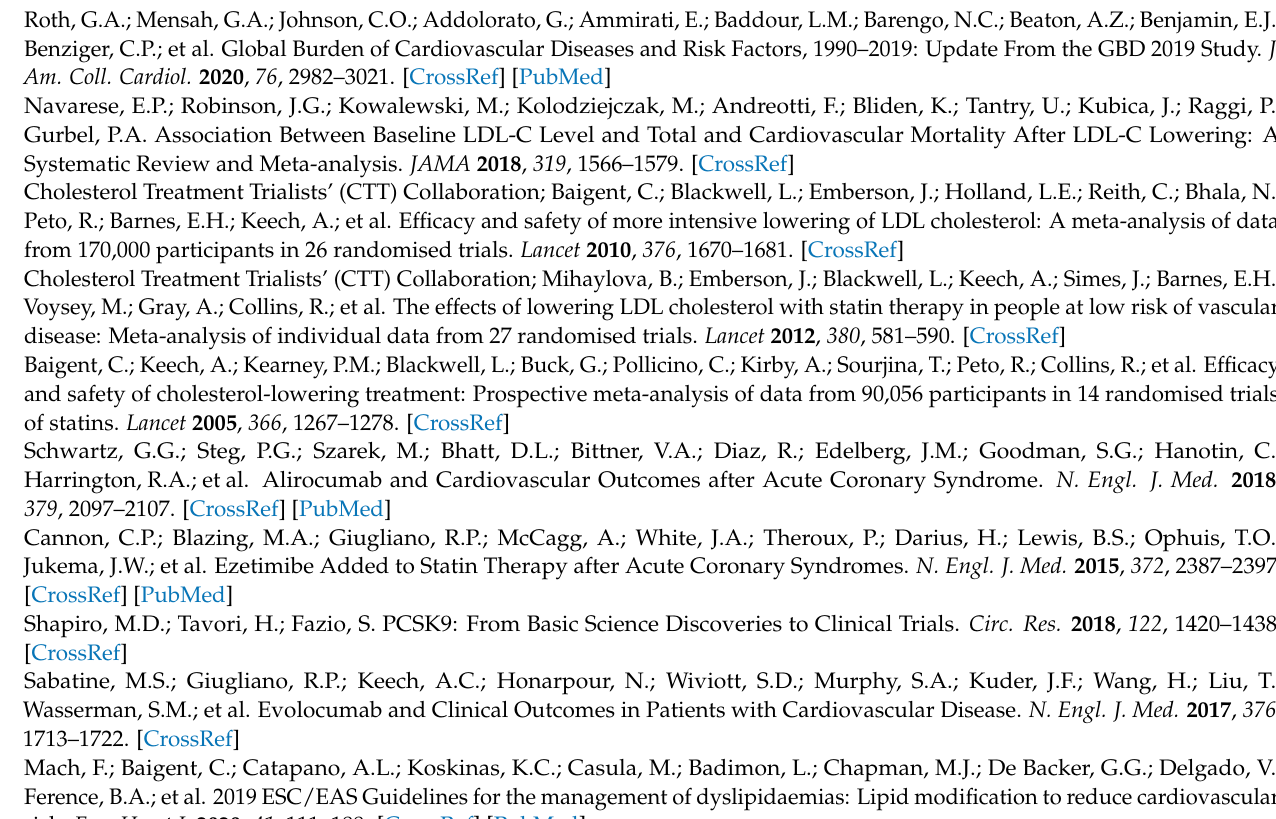
exemption codes; Table S3: Demographic and clinical characteristics for ASCVD patients stratified by type of lipid lowering